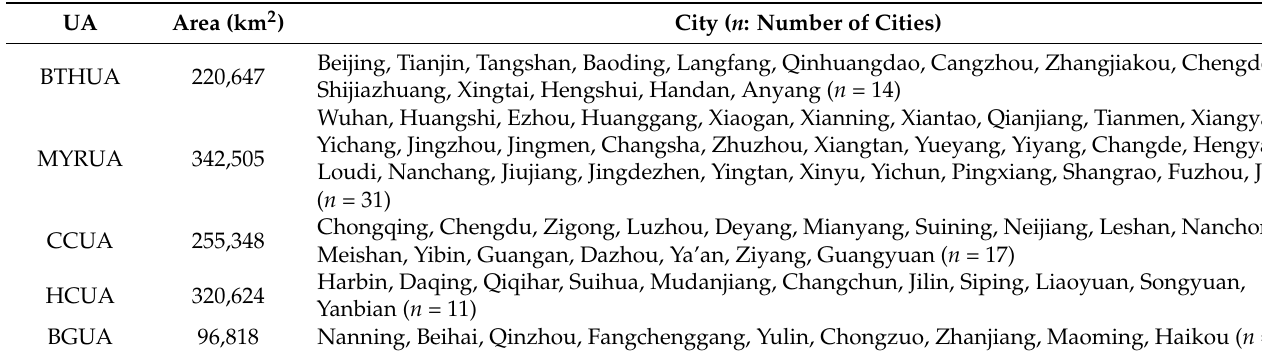
Table 1. Cities in the five